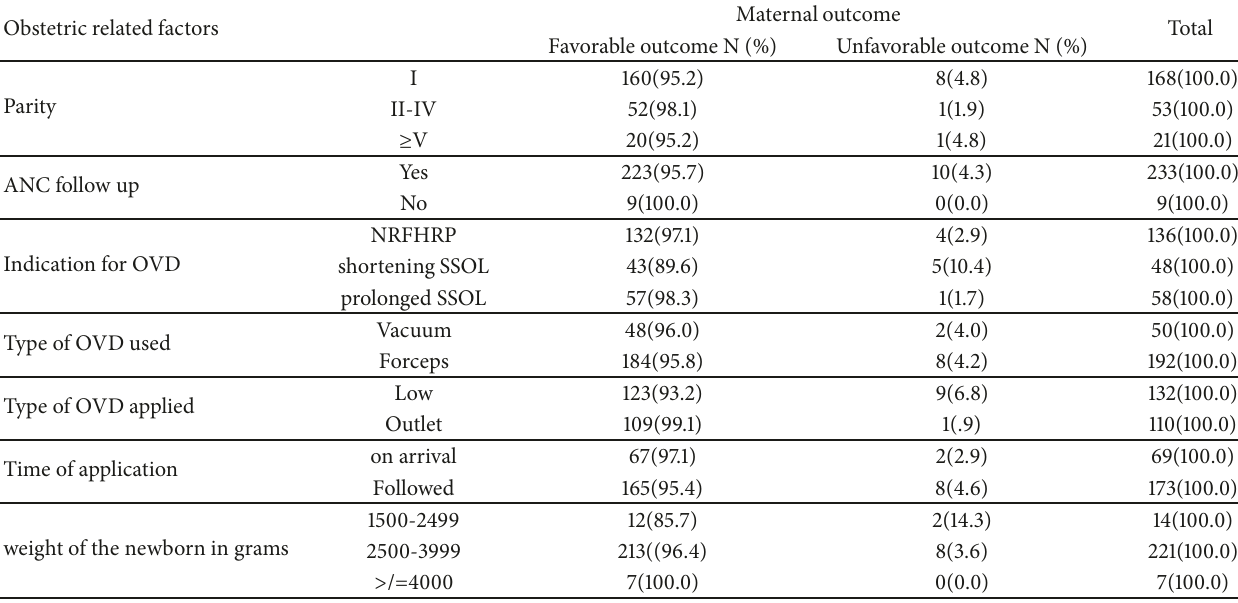
Table 6: Distribution of maternal outcome cross tabulated with maternal obstetric related variables among mothers who gave birth by OVD in JUMC December 1, 2016–May 30,